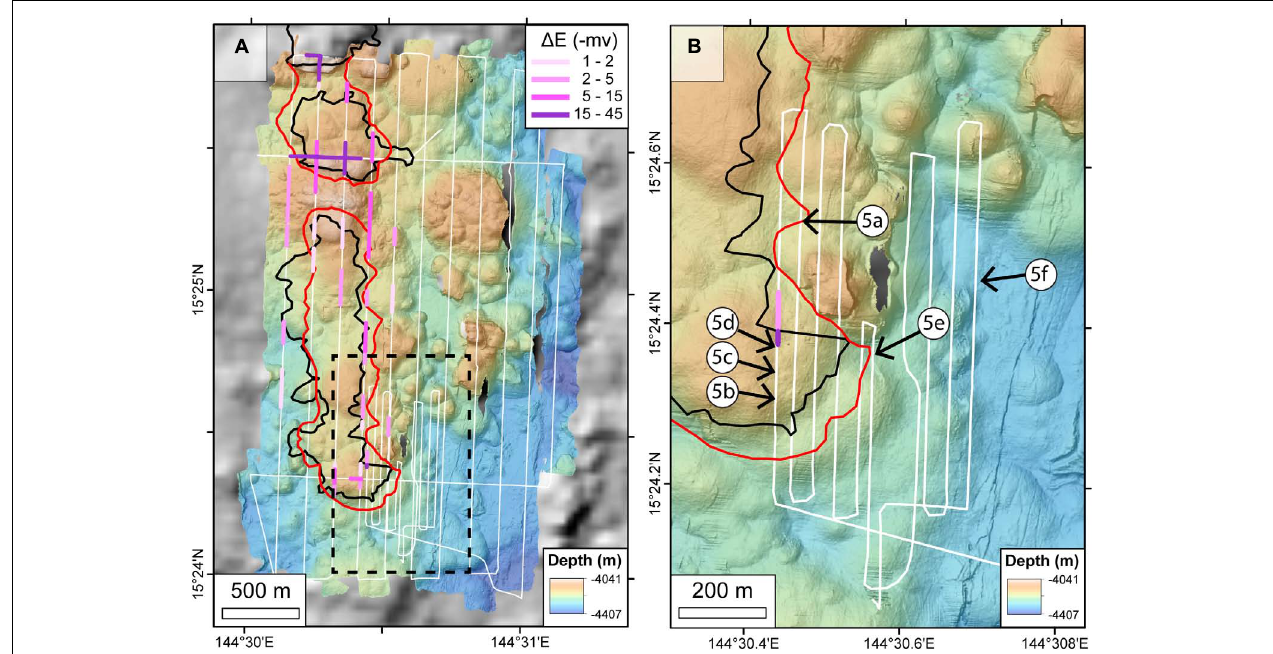
FIGURE 4 | AUV Sentry bathymetry from dive 367 with (cid:49) E anomalies from MAPR instrument shown as pink to purple colored lines (see inset for scale) overlain on Sentry track lines (white; widely spaced tracklines were 70 m above bottom). (A) Map of whole survey (modified from similar figure in Baker et al., 2017). Dashed black box is area of Figure 4B . (B) Detailed map of Sentry photo survey area (white track lines; 5 m above bottom). Black outlines show area of depth change between multibeam surveys; red outlines show edges of the 2013–2015 lava flows based on visual observations and interpreted from features in AUV Sentry bathymetry. AUV Sentry bathymetry was re-navigated and then shifted 60 m east and 20 m north to better match ground-truth from ROV dive observations.